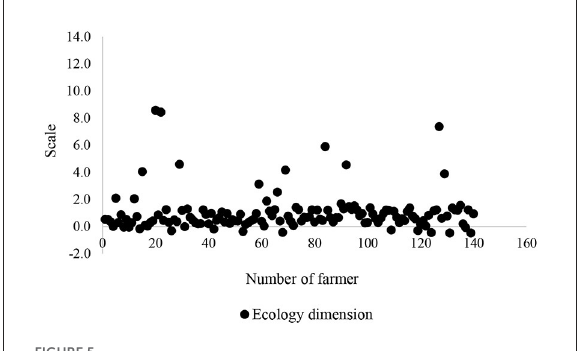
FIGURE5 Scatter of the ecology dimension of the agricultural sustainability of local farmers.